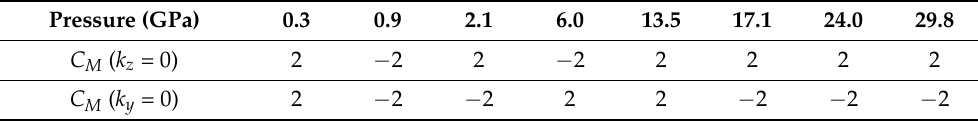
Figure 6. Mirror symmetric planes and Wilson loops at 0.3 GPa. ( a ) Orange, green, and yellow planes are mirror symmetric planes at k z = 0, π , and k y = 0, respectively. Wilson loops on the k z = 0, π , and k y = 0 are presented in ( b – d ), respectively. The horizontal dashed lines in each plot are the reference lines. Blue lines and green lines denote the flows of Wannier charge centers for states in subspaces of mirror +i and − i eigenvalues, respectively. Table 1. Mirror Chern number under different pressures. The first row denotes pressures in the unit of GPa. The second and third rows are mirror Chern numbers for k z = 0 and k y = 0 planes, respectively. Mirror Chern numbers for k z = π are always 0 under pressures in the table.